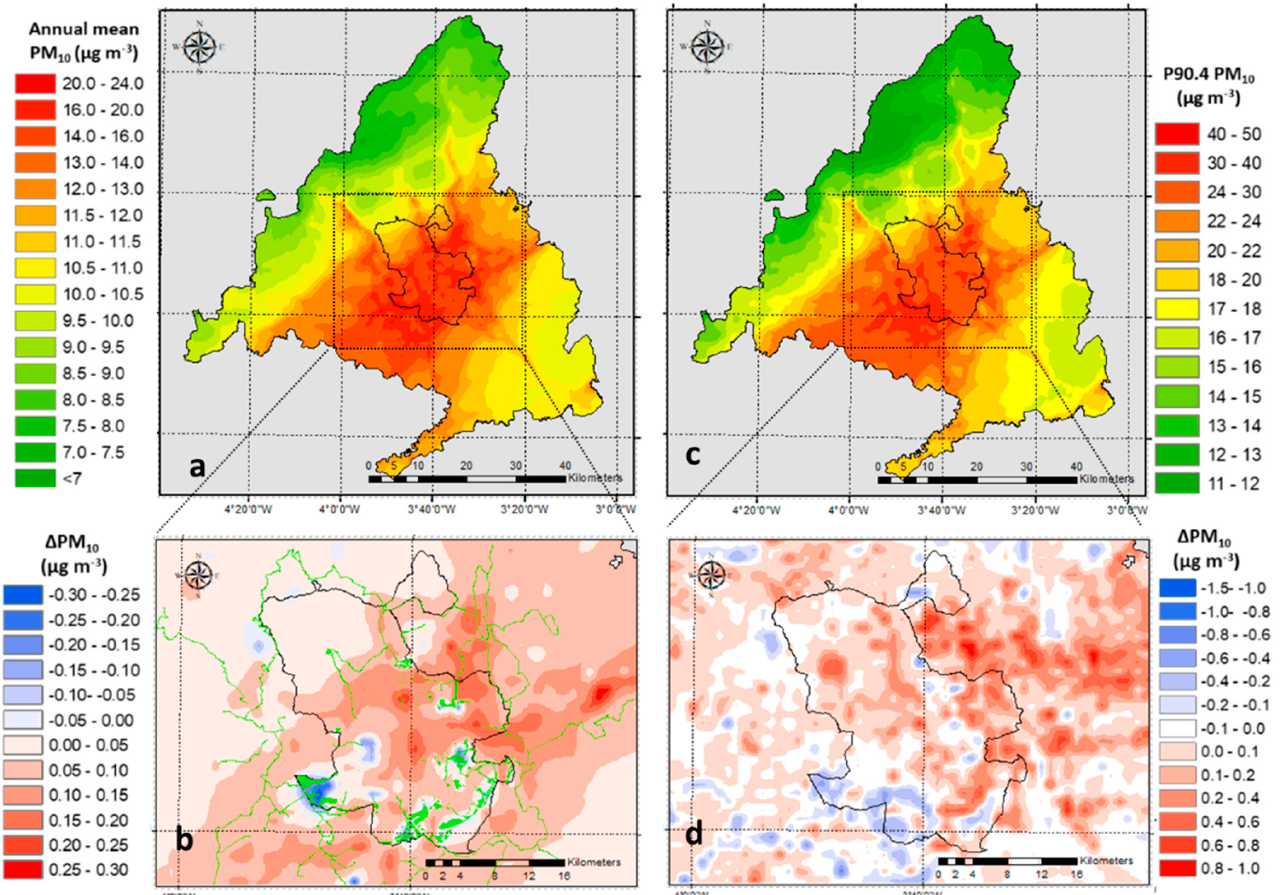
Figure 9. Annual mean of PM 10 (µg m − 3 ) for the Baseline Scenario ( a ) and expected variation (µg m − 3 ) due to future vegetation ( b ). Daily 90.4 PM 10 percentile (µg m − 3 ) for the Baseline Scenario ( c ) and expected variation (µg m − 3 ) due to future vegetation ( d ).